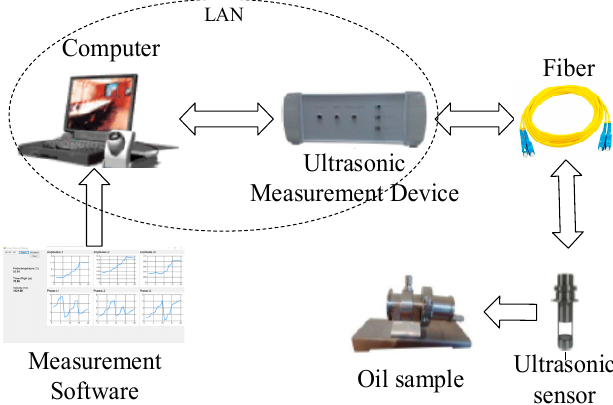
Figure 1. Structure chart of the Multi-frequency ultrasonic device.